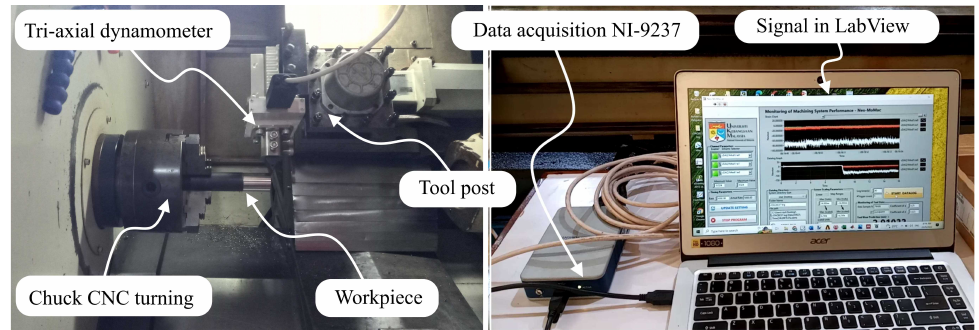
Figure 11. Machining setup for performance test of developed dynamometer.